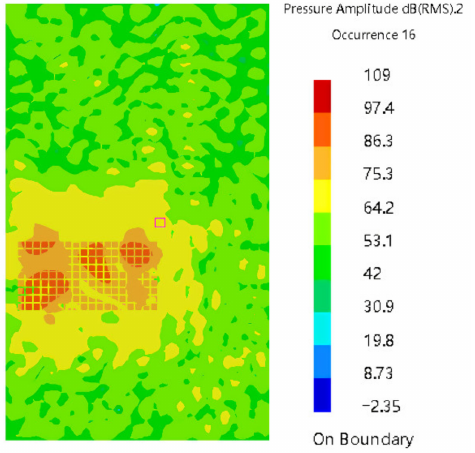
Figure 12. Acoustic grid sound pressure cloud